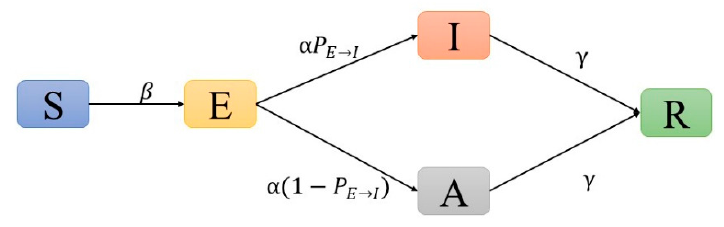
Figure 1. The structure of SEIAR model.